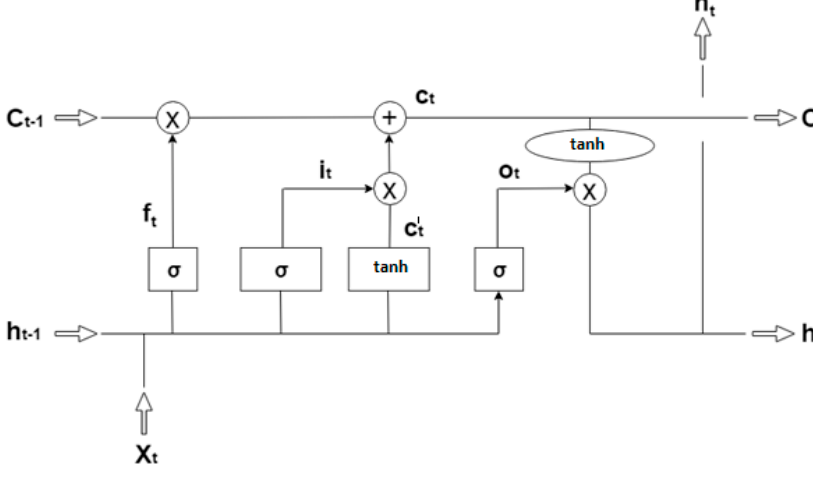
Figure 1. Schematic representation of LSTM.